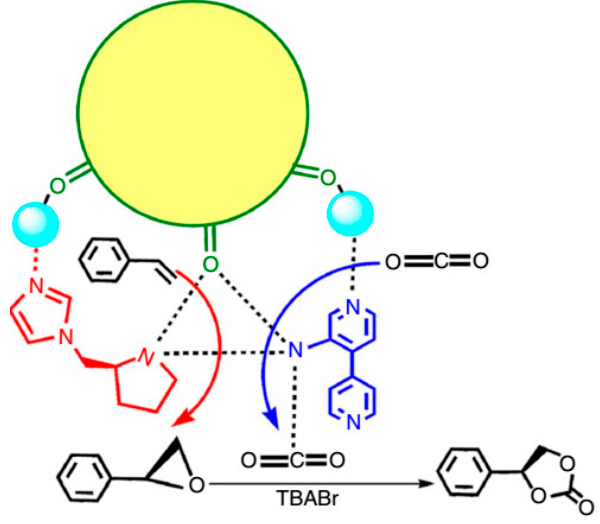
Figure 14. Diagram of potential mechanism for auto tandem catalysis. Reproduced from [54] with permission from Nature Publishing Group.